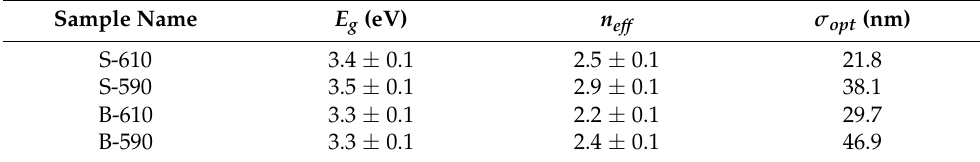
Table 3. Values of the optical constants of SnO 2 thin films: optical band gap ( E g ), effective index of refraction ( n eff ) and surface roughness, determined from the haze ratio ( σ opt ) determined from UV- Vis-NIR experiment.